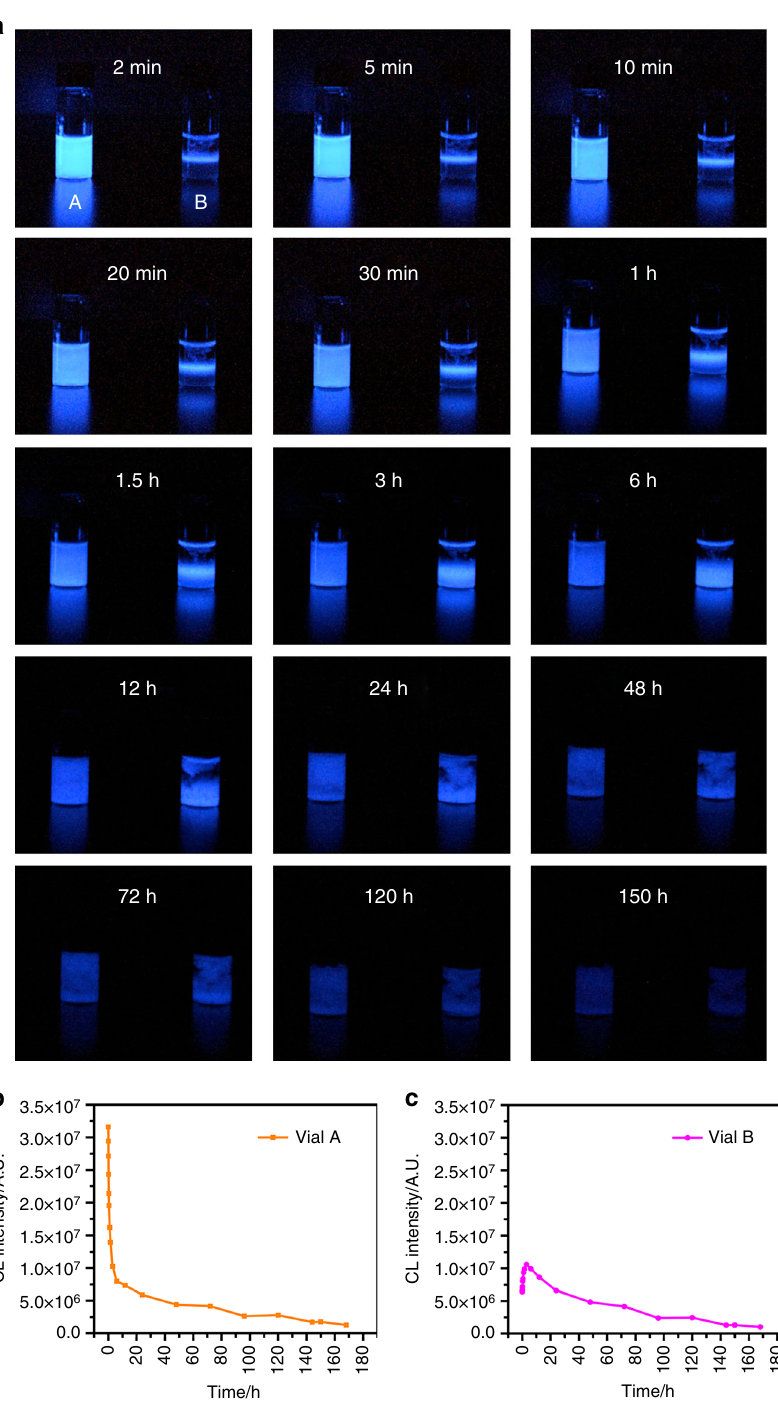
Fig. 4 Reaction of ABEI/Co 2+ /CS hydrogels with H 2 O 2 at different times. a Optical images using a digital camera. H 2 O 2 solution was fully mixed with ABEI/Co 2+ /CS hydrogels in vial A and H 2 O 2 solution was directly added into ABEI/Co 2+ /CS hydrogels without agitation in vial B. All the images are coded according to the same intensity scale. b , c CL intensity as a function of time for vial A and B, respectively. For ABEI/Co 2+ /CS hydrogels, 40 mM 1.5 ml ABEI, 1 mM 0.6 ml Co 2+ , 15 ml CS dispersed in alkaline solution. Reaction condition: 1 ml 0.1 M H 2 O 2, 1 ml